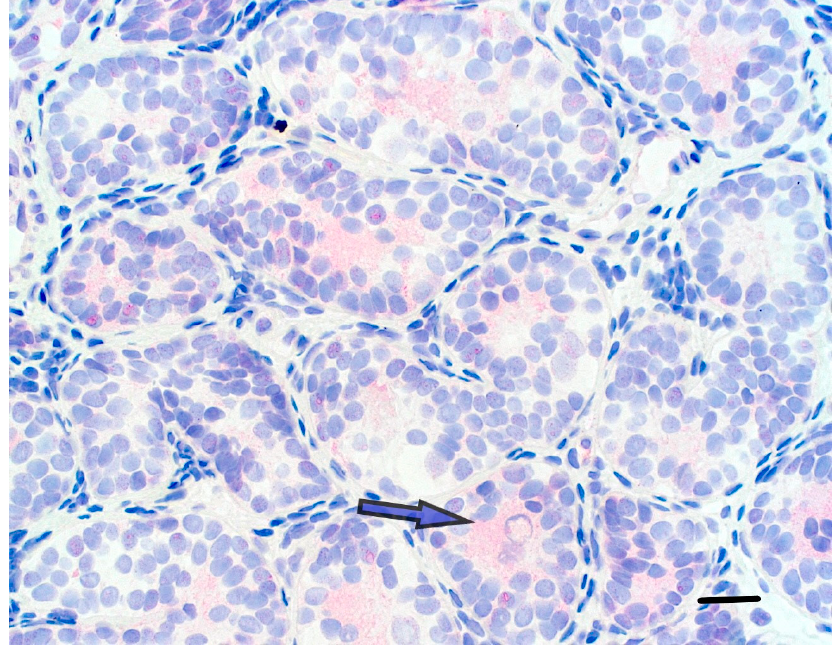
Figure 5. A testis from a HIR patient displaying weak PRDM9 cytoplasmic staining of the germ cells (arrow). Horizontal bar; 30 µ.